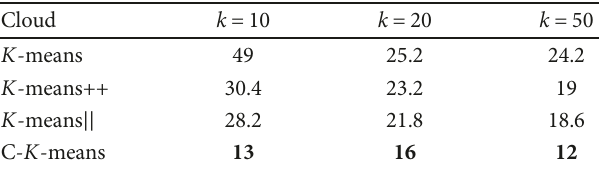
Table 12: Numbers of Lloyd ’ s iterations until convergence (averaged over 10 runs) for the Cloud dataset.